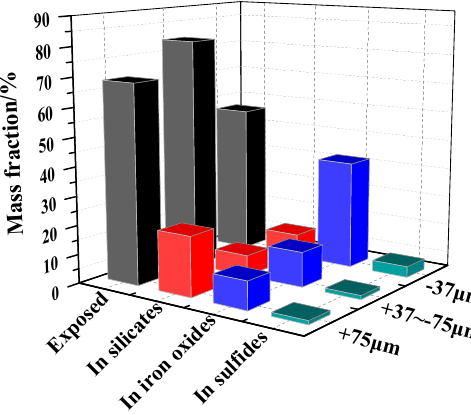
Figure 3. The result of gold phase in different size fractions of the calcine.